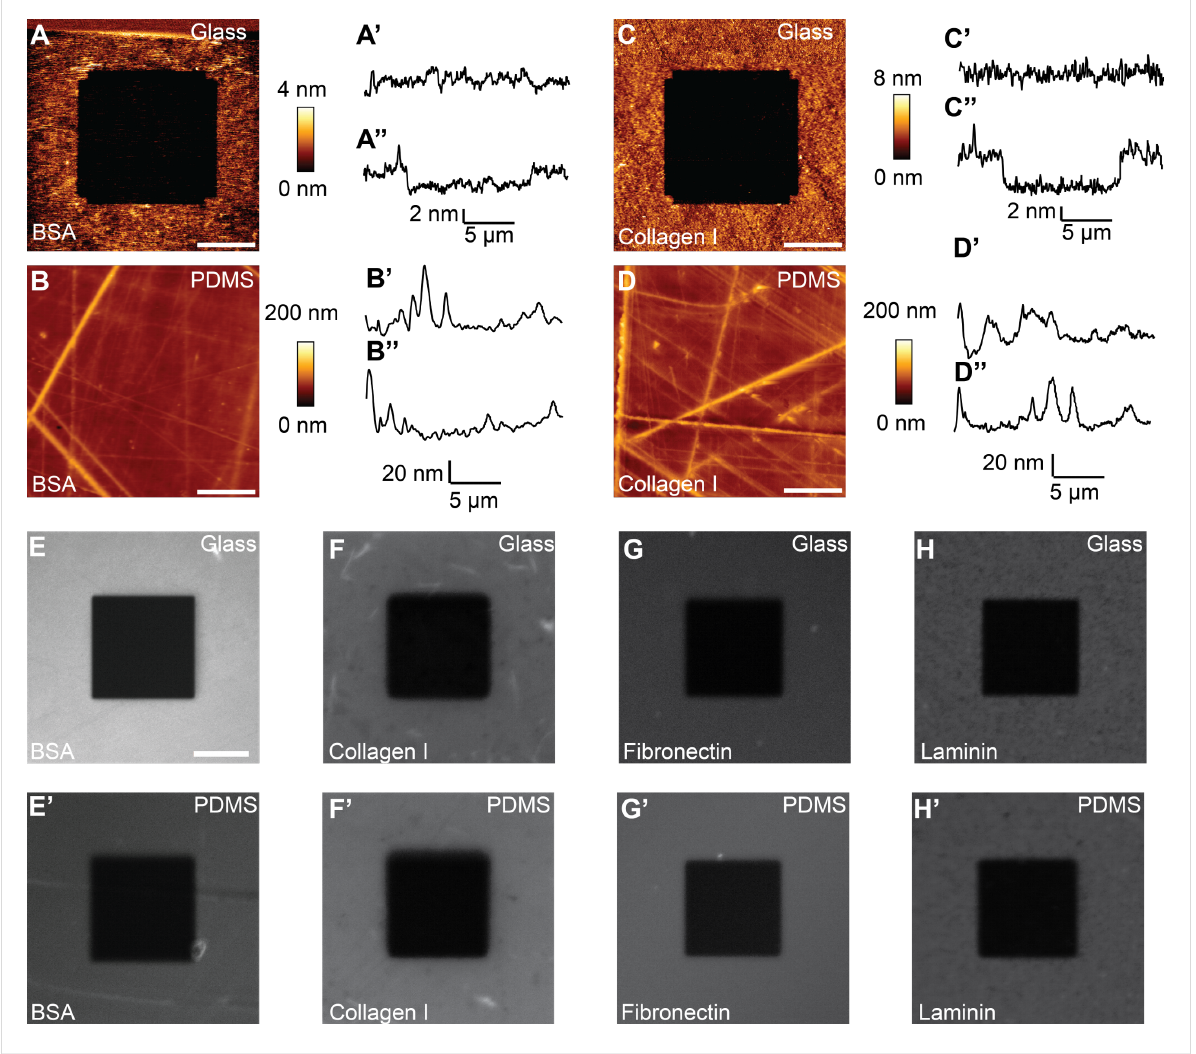
Figure 3: Surface characterization. Representative topographies of BSA-coated (A) and collagen I-coated (C) glass surfaces, and BSA-coated (B) and collagen I-coated (D) PDMS surfaces. A 20 × 20 µm 2 area of the coated surface was imaged with AFM after a 10 x 10 µm 2 area was repeatedly scratched by contact-mode AFM imaging using a high contact force. Images show a cavity in the scratched area for BSA- (A) and collagen I-coated (C) glass surfaces. The thicknesses of the coatings were similar, ≈ 3.5 nm for BSA (A’’) and ≈ 4.5 nm for collagen I (C’’). The PDMS surface showed a rough surface with height differences of >40 nm (B and D). On PDMS, the displacement of proteins by AFM scratching was not evident (B, B’’ and D, D’’). Scale bars, 5 µm. Since a protein coating was not demonstrated, we coated PDMS wells with fluorescently labeled BSA (FITC), collagen I (FITC), fibronectin (rhodamine) and laminin (HiLyte488) and imaged the glass (E–H, respectively) and PDMS (E’–F’) surfaces. Using confocal microscopy, a 20 × 20 µm 2 area was bleached with maximum laser power before the 50 × 50 µm 2 area was imaged (E–H and E’–H’). Scale bar, 10